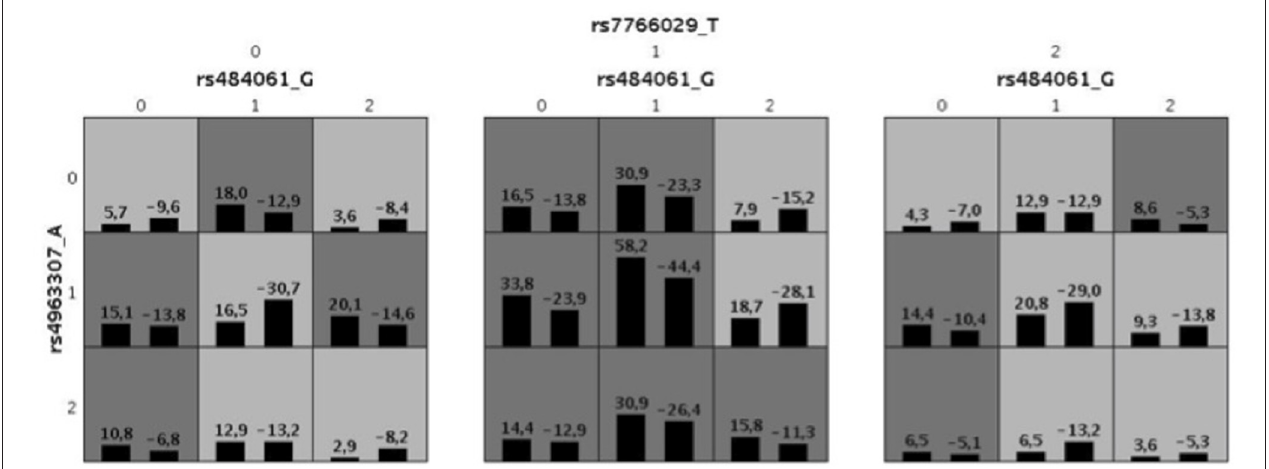
FIGURE 1 | Illustration for the best combination defined by GMDR for 69 SNPs for AUDIT. The allele code is defined by minor allele numbers of rs484061 (allele G), rs4963307(allele A) and rs7766029 (allele T). The numbers above the histogram bar, indicate the sum of “positive” (above the averaged score = 0) and “negative” (below the averaged score = 0) scores by the combination of genotypes. Also, the dark gray indicates a high-risk combination of the genotypes with alcoholism and light gray for low risk. It defined by sum of positive and negative score, when it’s < 0 for low-risk and > 0 for